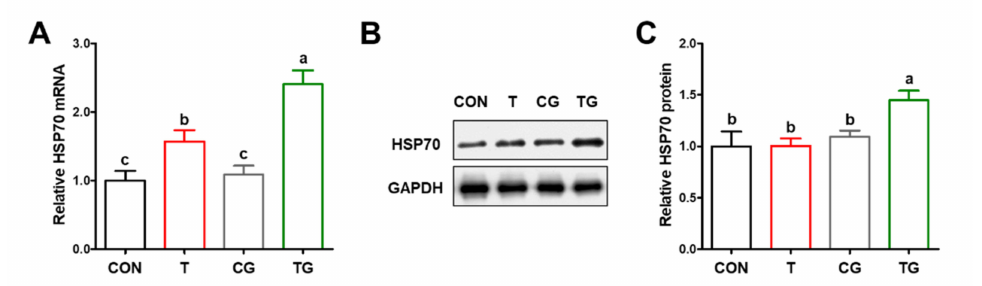
Figure 1. Effect of intraperitoneal injection of glutamine on levels of heat shock protein 70 (HSP70) in pectoralis major muscles of broiler chickens subjected to pre-slaughter transport. ( A ) Relative mRNA expression of HSP70. ( B , C ) Relative protein content of HSP70. ( C ) CON, broilers received intraperitoneal injection of saline and were held under a normal rearing condition; T, broilers that received intraperitoneal injection of saline and were subjected to pre-slaughter transport treatment; CG, broilers that received intraperitoneal injection of glutamine and were held under a normal rearing condition; TG, broilers that received intraperitoneal injection of glutamine and were subjected to pre-slaughter transport treatment. All measurements are expressed as means ± SE ( n = 6) with different superscript letters (a–b) indicating significance ( p <